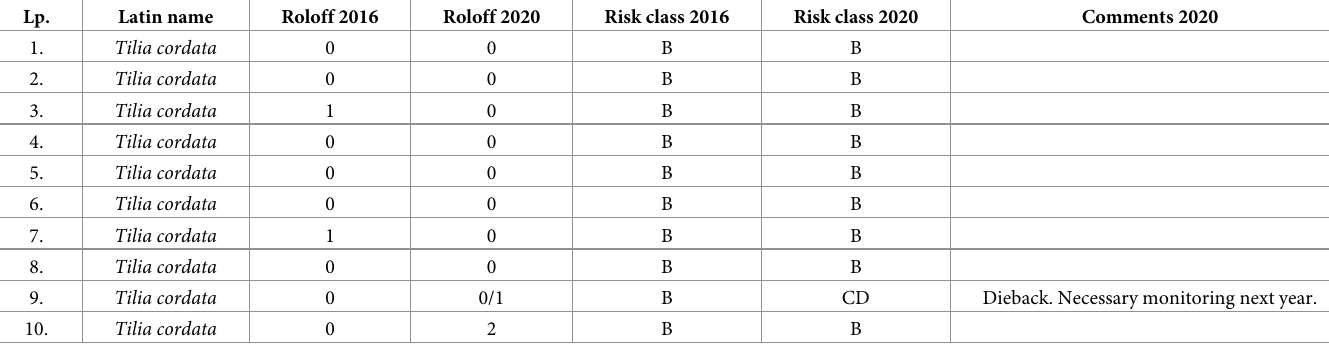
Table 4. Tree vitality, safety evaluation and detailed characteristic of wounds in control trees.